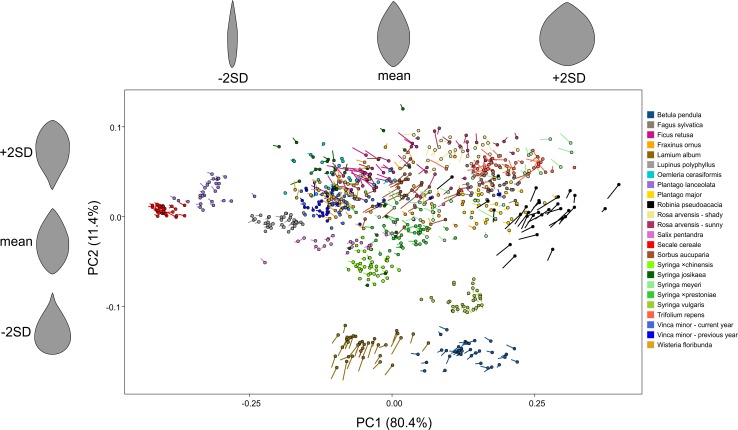
Scatterplot for results of principal component analysis of elliptic Fourier descriptors.Small circles indicate position of fresh leaf shape in the PC1–PC2 morphospace, while the lines show the shape change. Individual scatterplots are presented in Fig 2. Patterns of variation along PC1 and PC2 axes are shown on the top and on the left of the plot, by a mean shape and shapes +2 and -2 standard deviation (SD) distant from the mean.